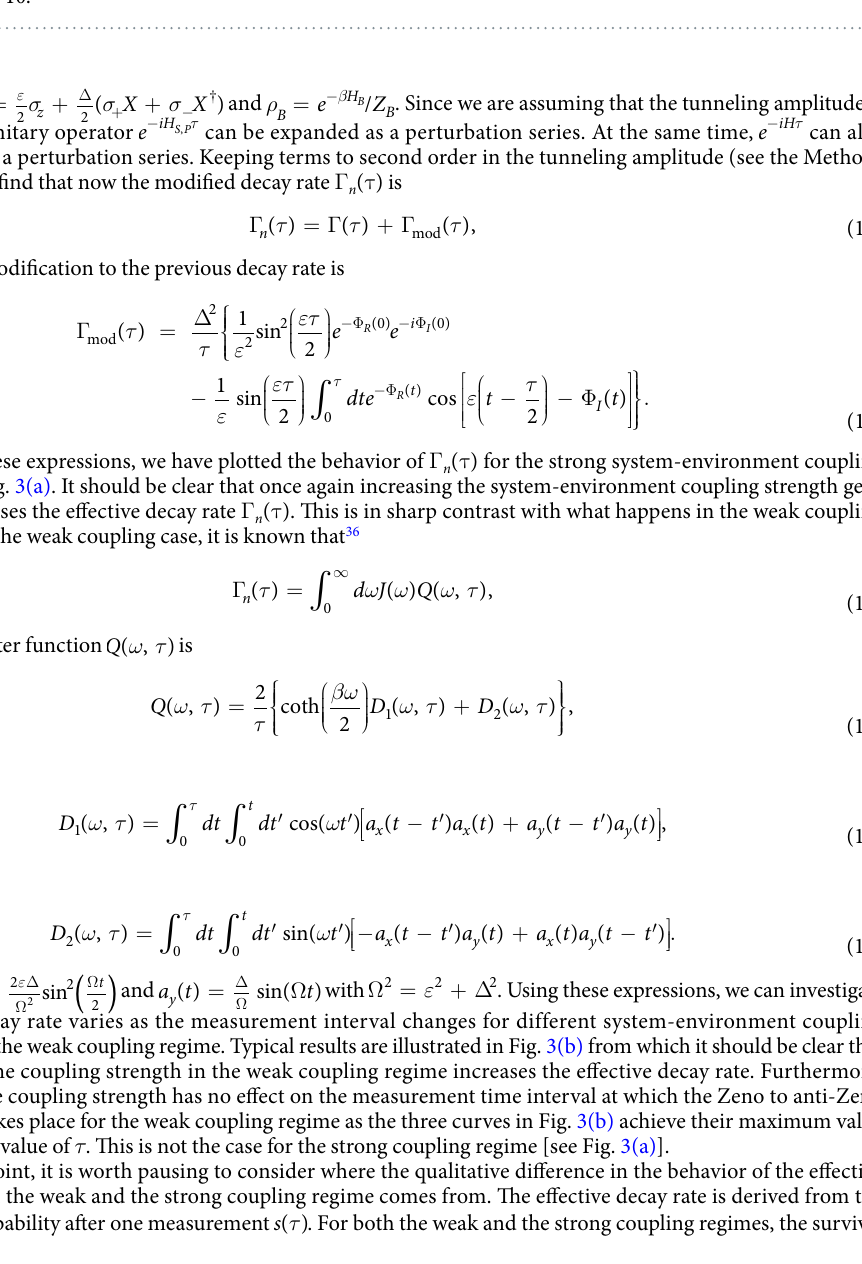
. Since we are assuming that the tunneling amplitude is small, the unitary operator τ − e iH SP , can be expanded as a perturbation series. At the same time,